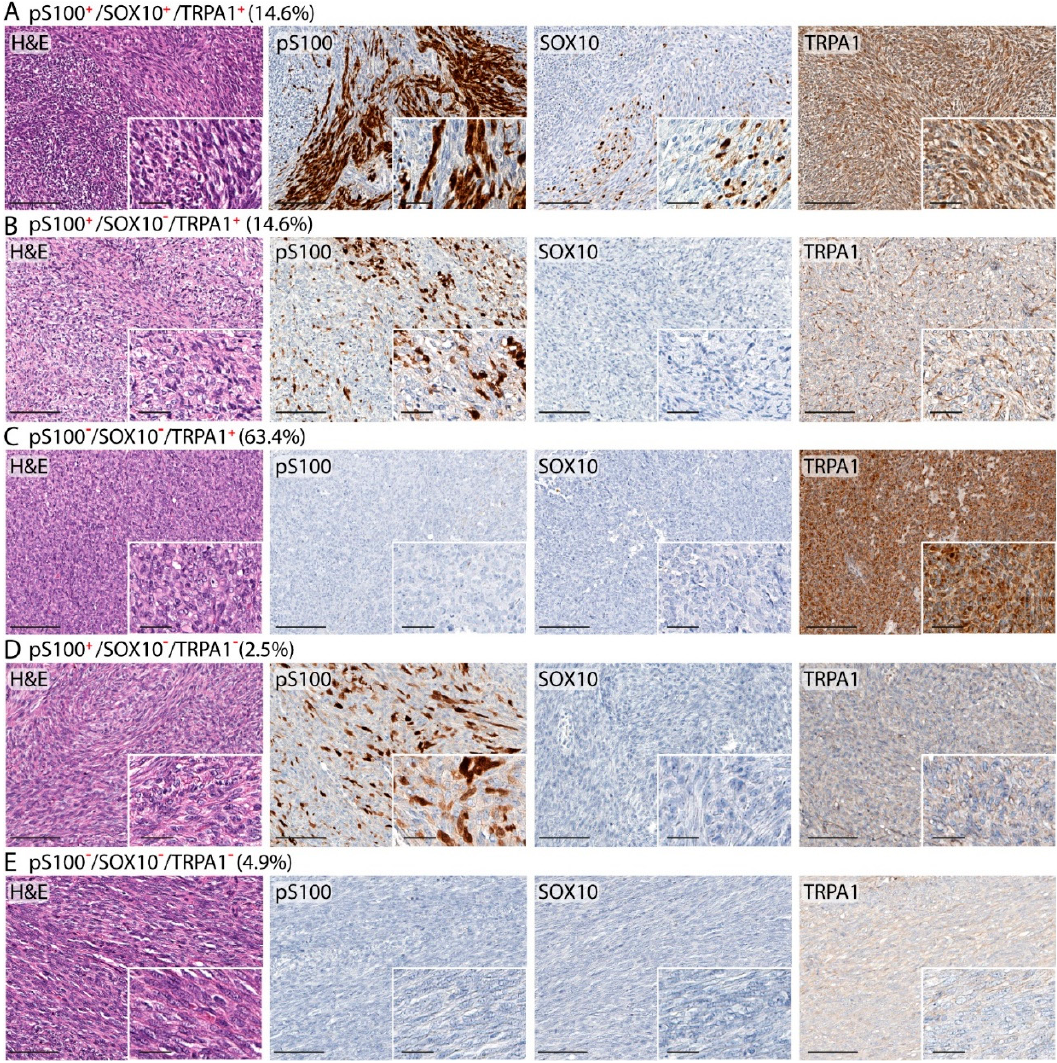
Figure 2. Representative photomicrographs reporting hematoxylin and eosin (H&E) and percentage of SS samples with TRPA1 staining positive to pS100 and SOX10 ( A ); positive to pS100 and negative to SOX10 ( B ); negative to both pS100 and SOX10 ( C ). Representative photomicrographs of SSs negative with TRPA1 staining and positive with pS100 ( D ) or negative with both pS100 and SOX10 ( E ). Magnification ×200, inset ×400 (Scale bars: 100 μ m, inset 20 μ m). To further confirm a neural origin for SSs expressing TRPA1, di ff erent markers (SNAIL + SLUG), usually expressed by the stem cells of the neural crest, were tested. Among the SSs, 35 / 41 (85%) were positive with SNAIL + SLUG. In addition, data showed that 32 / 41 (78%) SSs positive with SNAIL + SLUG were also positive with TRPA1 staining; 6 / 41 (15%) SSs resulted in being positive with TRPA1, but negative with SNAIL + SLUG, and 3 / 41 (7%) were negative with TRPA1 and positive with SNAIL + SLUG (Figure